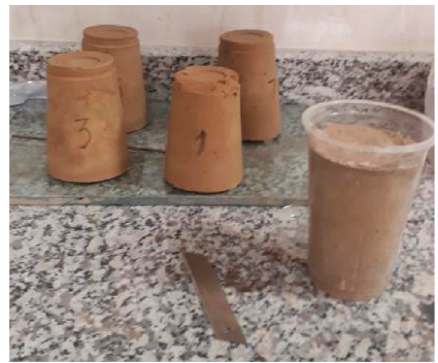
Figure 7: Steps of preparation, mixing, sample making, and processing.